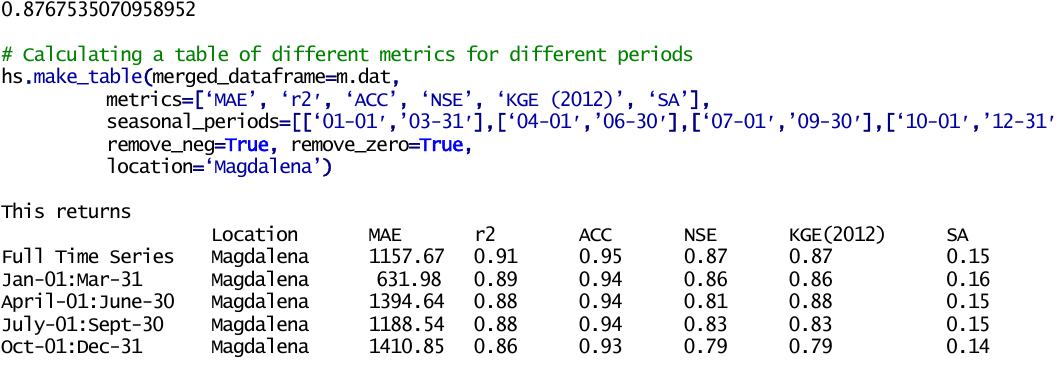
# Calculating a table of different metrics for different periods hs.make_table(merged_dataframe=m.dat,